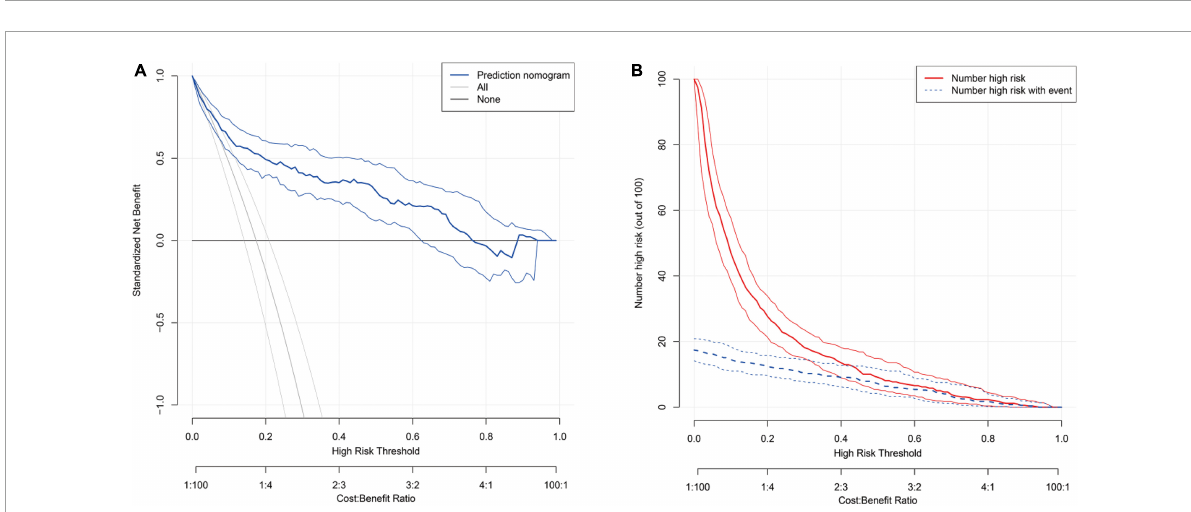
FIGURE4 (A) The decision curve for the predicting delayed graft function (DGF) in the Intention-To-Treat set ( n = 517). The thick blue line represents the model; the light gray line represents the assumption that all patients have DGF; the thick gray line represents the assumption that all patients have non-DGF. The threshold probability in the Per-Protocol set and Intention-To-Treat data set both are about 20%, using serum cystatin C (S-CysC) to diagnose DGF could yield a clinical benefit rate of 50%. (B) The clinical impact curve of the S-CysC based risk model showed the predicted positives cases included all the actual positives cases with 1:4 cost/benefit ratio. Of 100 patients, the heavy red solid line showed the total number who would be deemed high risk for each risk threshold. The dotted blue line shows how many of those would be true positives